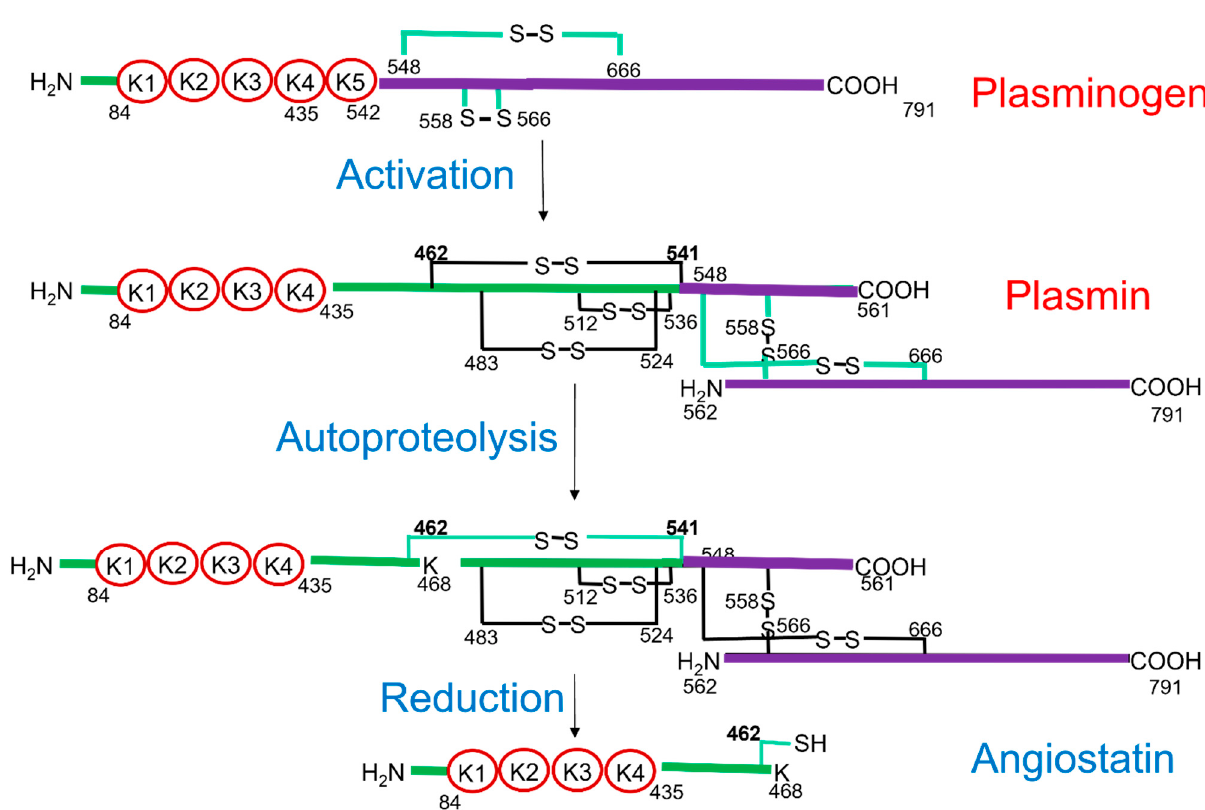
Figure 5. Mechanism of angiostatin formation from plasminogen. The formation of the plasminogen fragment, angiostatin, from plasminogen involves three steps. The first involves the conversion of plasminogen to plasmin by plasminogen activators (tPA, uPA) and the stimulation of that process by the S100A10 subunit of AIIt. The second involves the AIIt-dependent stimulation of plasmin autoproteolysis. The third involves the reduction of autoproteolyzed plasmin by the ANXA2 subunit of AIIt.